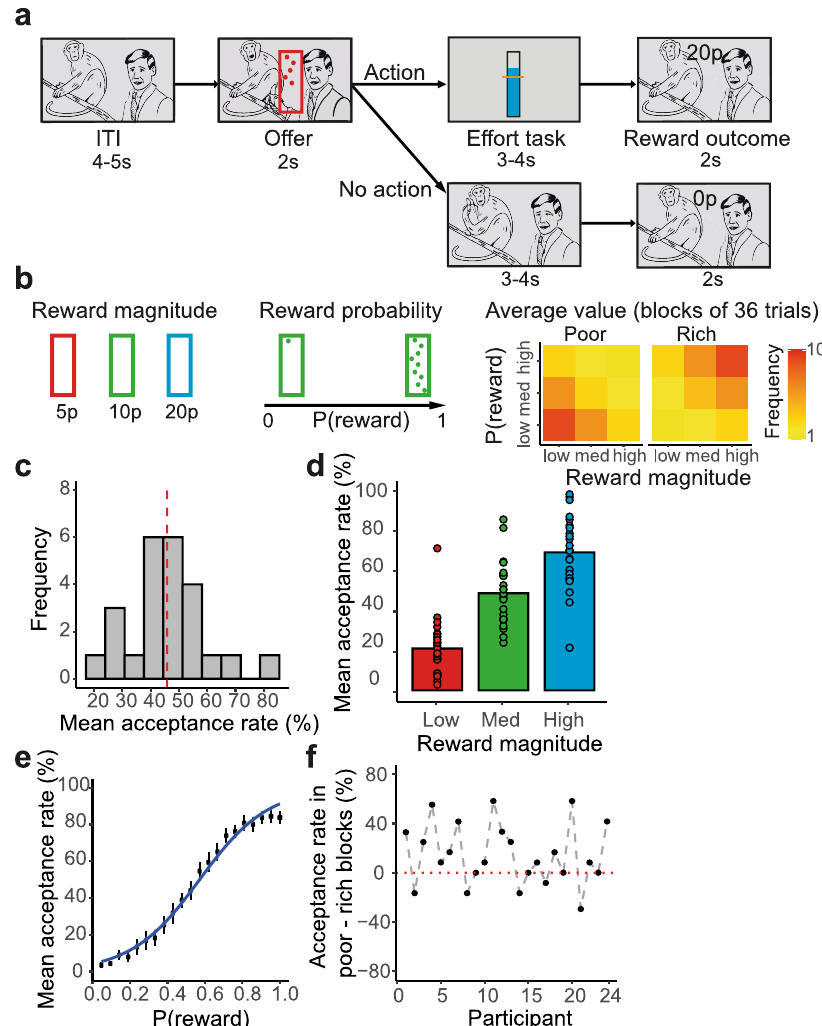
Fig. 1 Experimental task and the main behavioural results. a While watching a movie, participants received a series of offers in the form of visual stimuli that were superimposed upon the movie. Each offer appeared for 2 s and could be accepted by button-pad response while it remained on-screen. Offer stimuli consisted in centrally presented vertical rectangles which contained small circular dots. The colour of the offer represented reward-magnitude and the number of dots indicated the reward-probability. If the participant made a response to accept an offer (action), the movie was interrupted, and the participant needed to complete a short effort-task for a duration of 3 − 4 s. If the force was successfully exerted, the participant became eligible for a monetary reward of the probability and magnitude indicated by the accepted offer. The movie resumed once the effort-task was completed, and feedback about the reward outcome was superimposed on-screen for 2 s. If the offer was not accepted (no-action), participants continued to watch the movie uninterrupted for a duration equivalent to the effort-task but would receive no monetary reward. The next offer appeared after an inter-trial-interval (ITI) of 4 − 5 s. b We asked whether contextual factors in participants ’ environments in fl uenced their decisions to act (i.e., to accept an offer by making a response). These factors included: (1) Offer reward magnitude with three levels: low (5p), medium (10p) or high (20p), indicated by red, green or blue (magnitude-to- colour contingencies were counterbalanced across participants). (2) Reward probability, which increased linearly with the number of dots comprising the stimulus. (3) Average value of the environment which was manipulated by changing the ratio of high magnitude and high probability offers within blocks. c The distribution of response rate (act/no-act decisions). The red dashed line is the average response rate across participants. d − f Participants ( n = 24) were more likely to act when offered a large magnitude reward ( d ), a high probability reward ( e ), and when they were in a poor compared to a rich block ( f ). In panel ( d ) each ring represents one participant, and the columns illustrate the group mean. In panel ( e ) the black points and the error bars are mean response rate and standard error of the mean at each discrete level of reward-probability, respectively, across participants. Panel ( f ) shows the difference in acceptance rate of similar offers (medium magnitude and medium probability) between poor and rich blocks, for each participant. Source data are provided as a Source Data fi